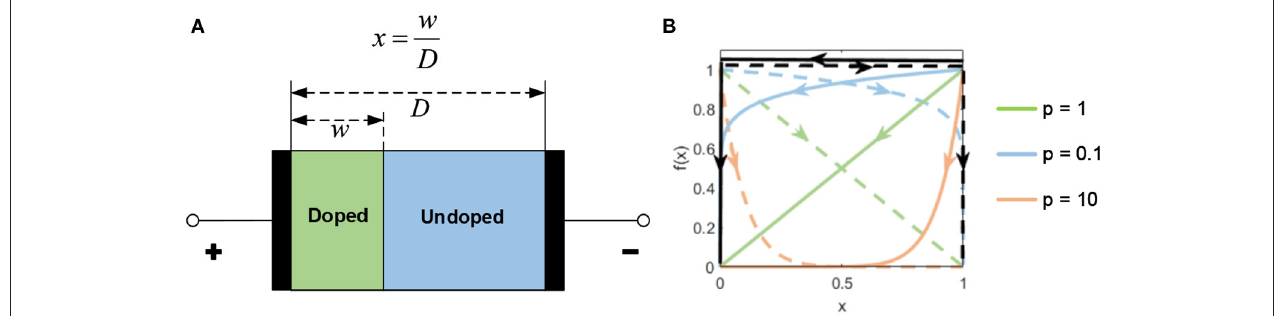
FIGURE 3 | (A) The HP model. (B) The window function.